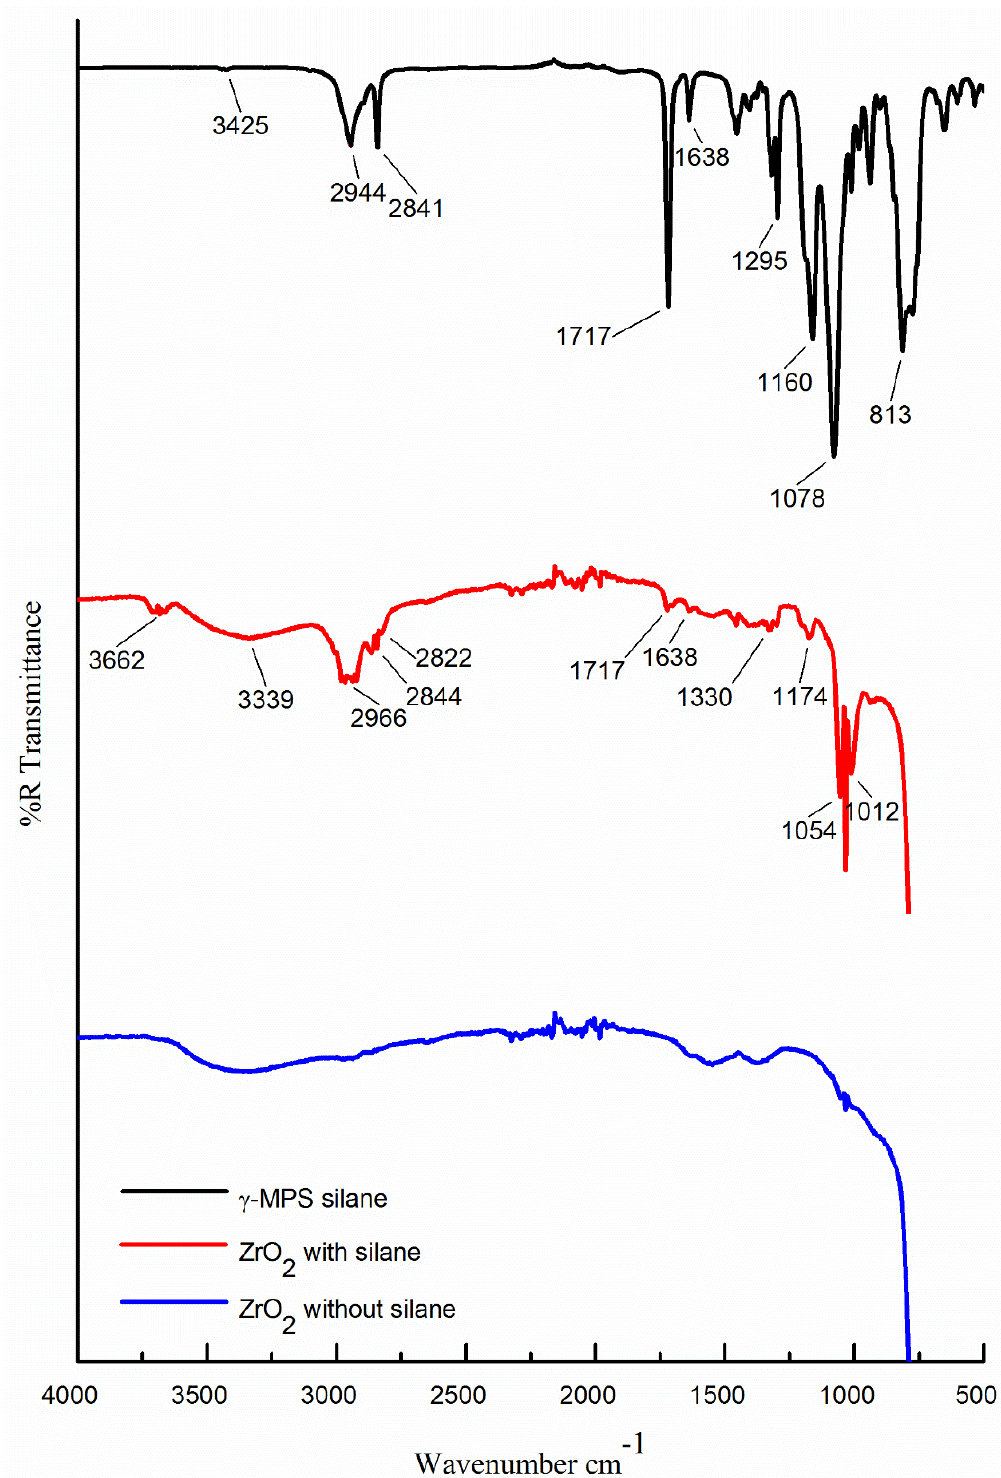
Figure 3. FTIR spectra showing (black curve, top) silane coupling agent ( γ -MPS), (red curve, middle) zirconia nanoparticles after treatment with silane ( γ -MPS) and (blue curve, bottom) zirconia nanoparticles without silane. Table 2. Bond type and wavelength of Silane coupling agent, 3-trimethoxysilyl propyl methacry- late ( γ -MPS) and silanised zirconia nanoparticles.